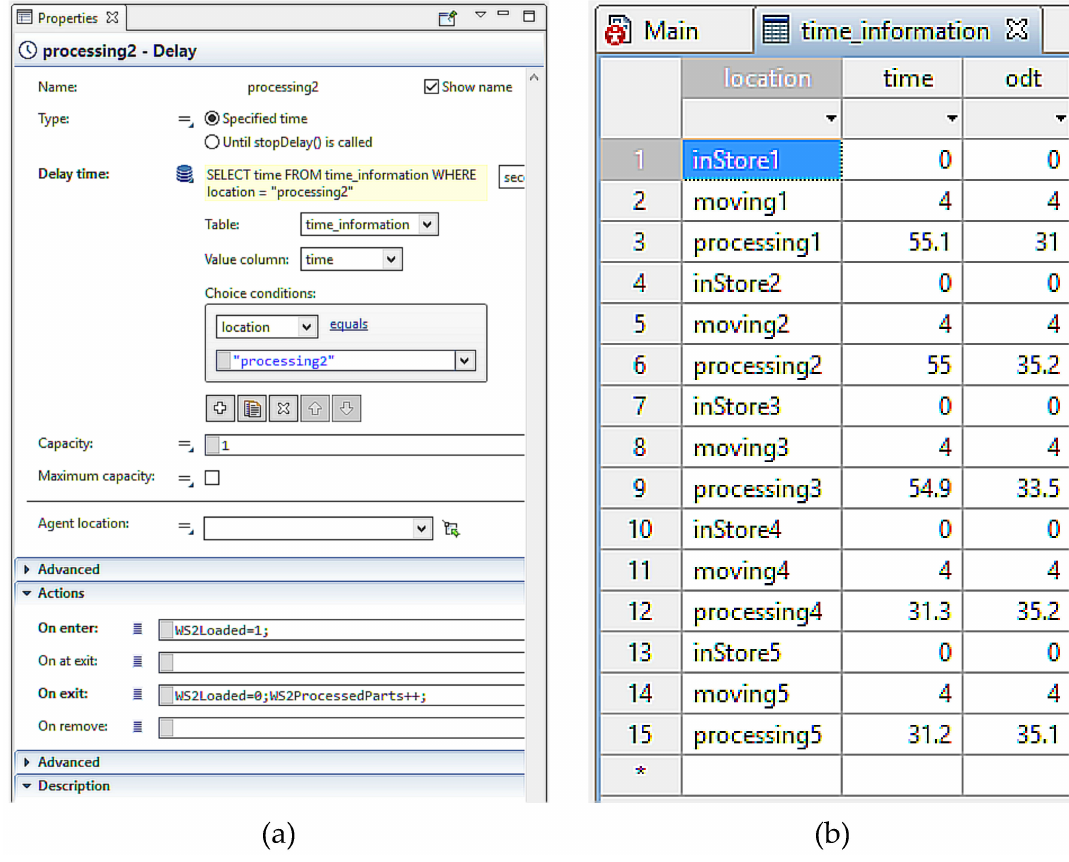
Figure 4. AnyLogic project ( a ) Object design; ( b ) Time information in the